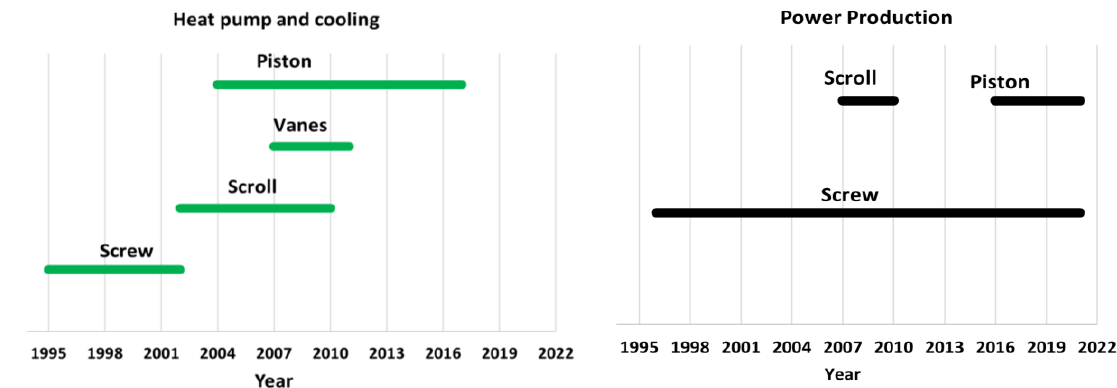
Figure 19. Timeline of the research about two-phase volumetric expanders.